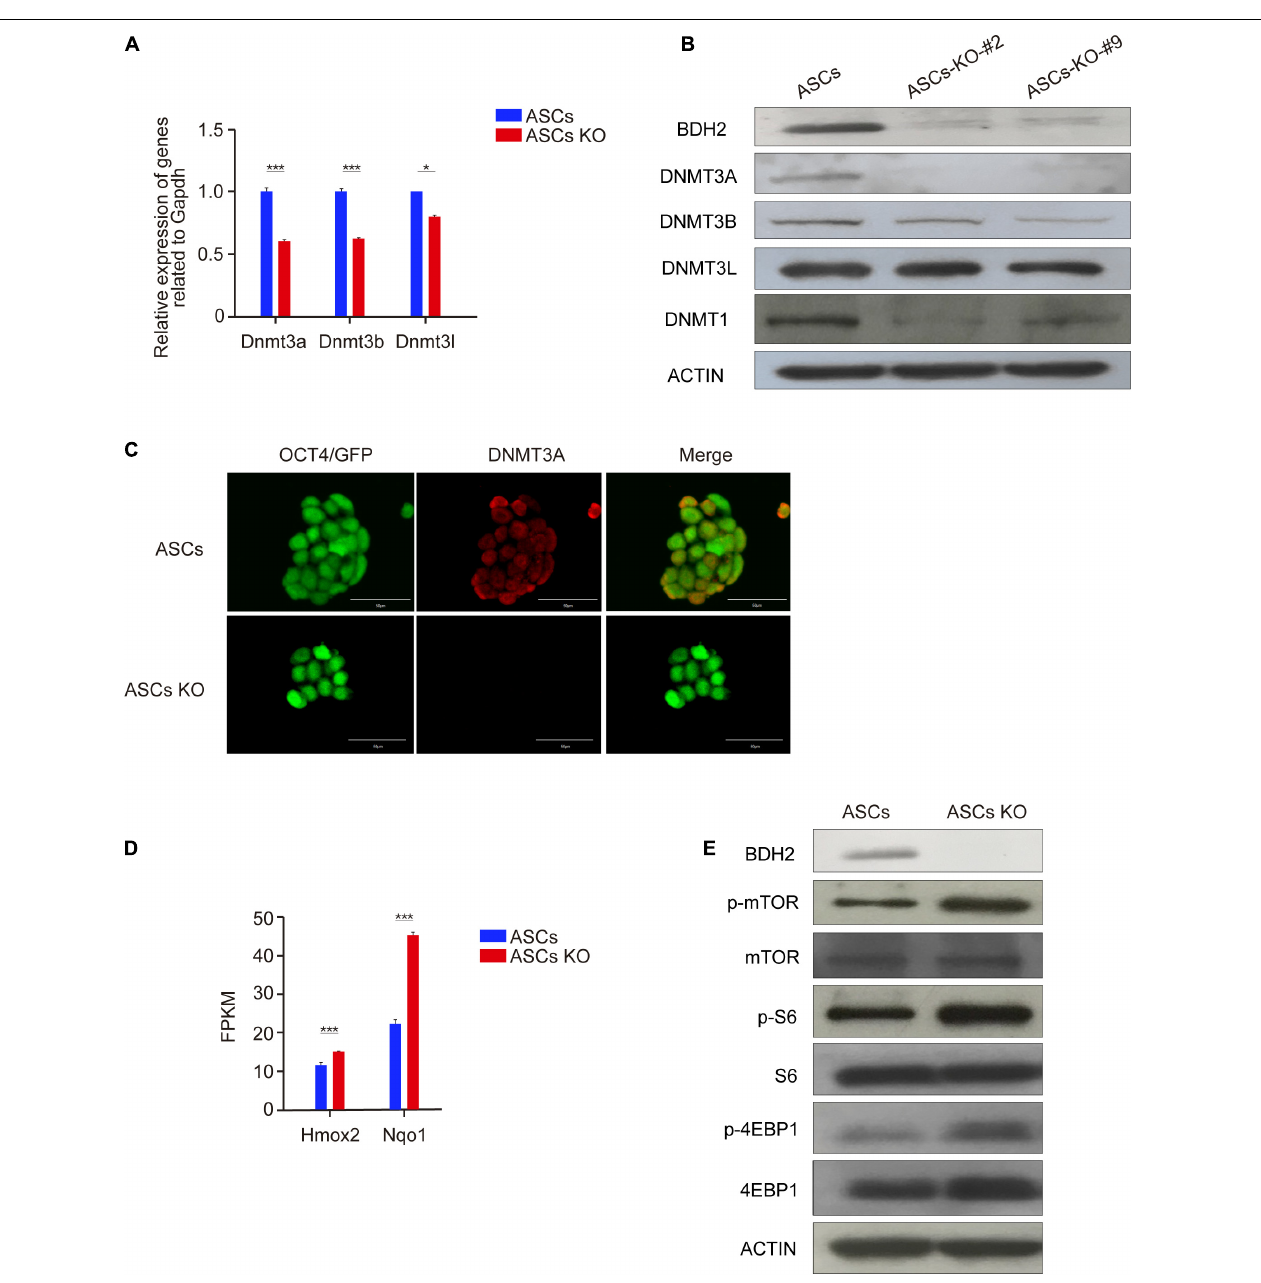
FIGURE 4 | Bdh2 knockout regulates DNA methylation in ASCs. (A) Real-time PCR analysis of DNA methyltransferase genes expression (Dnmt3a, Dnmt3b, and Dnmt3l) in the Bdh2 -knockout ASCs, ASCs were used as control. Data were obtained in triplicate and presented as mean ± SD. p -values were calculated by two-way ANOVA, * p < 0.05, *** p < 0.001. (B) Western blotting analysis for BDH2, DNMT3A, DNMT3B, DNMT3L, and DNMT1 in two Bdh2 -knockout ASCs. (C) Immunostaining of DNMT3A in Bdh2 -knockout ASCs and ASCs. Scale bars, 50 µ m. (D) Expression levels of oxidative stress-related key genes were tested by RNA-Seq analysis. Data were obtained in triplicate and presented as mean ± SD. p -values were calculated by two-way ANOVA, * p < 0.05, *** p < 0.001. (E) The effect of Bdh2 knockout on mTOR signaling pathway in ASCs was detected by Western blotting.